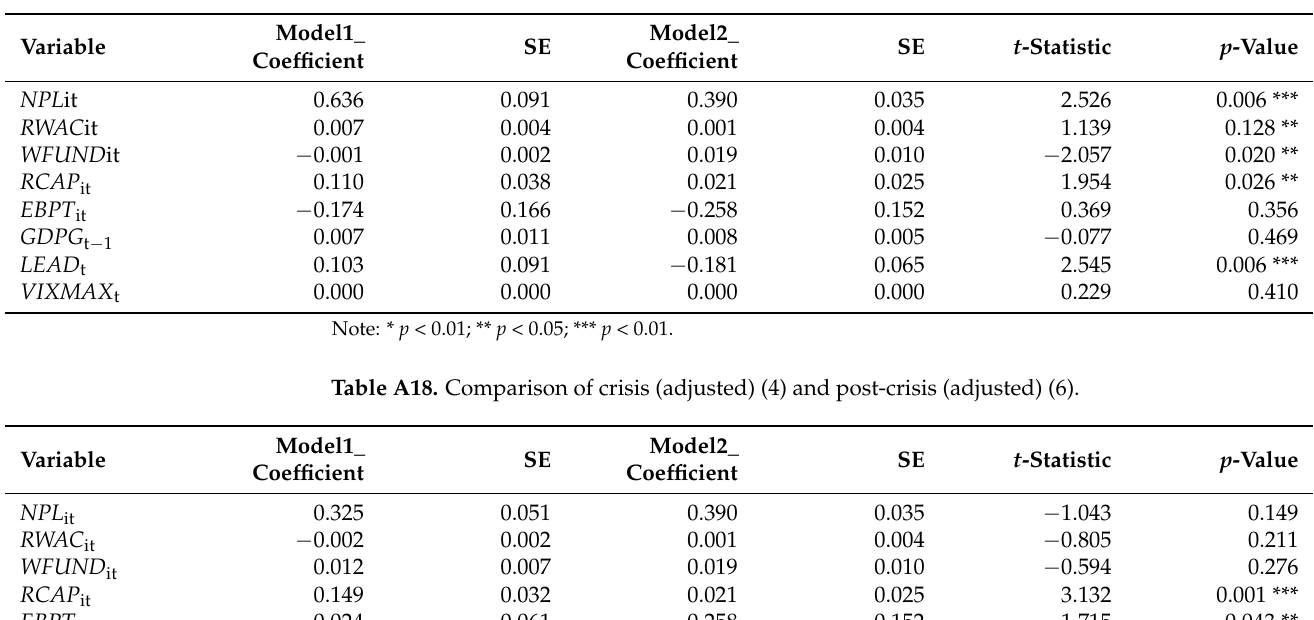
Table A17. Comparison of pre-crisis (adjusted) (2) and post-crisis (adjusted) (6).